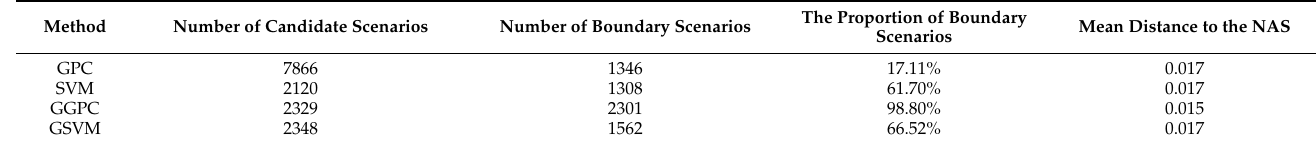
Table 7. Performance of the four classifiers in generating high-quality candidate scenario sets.